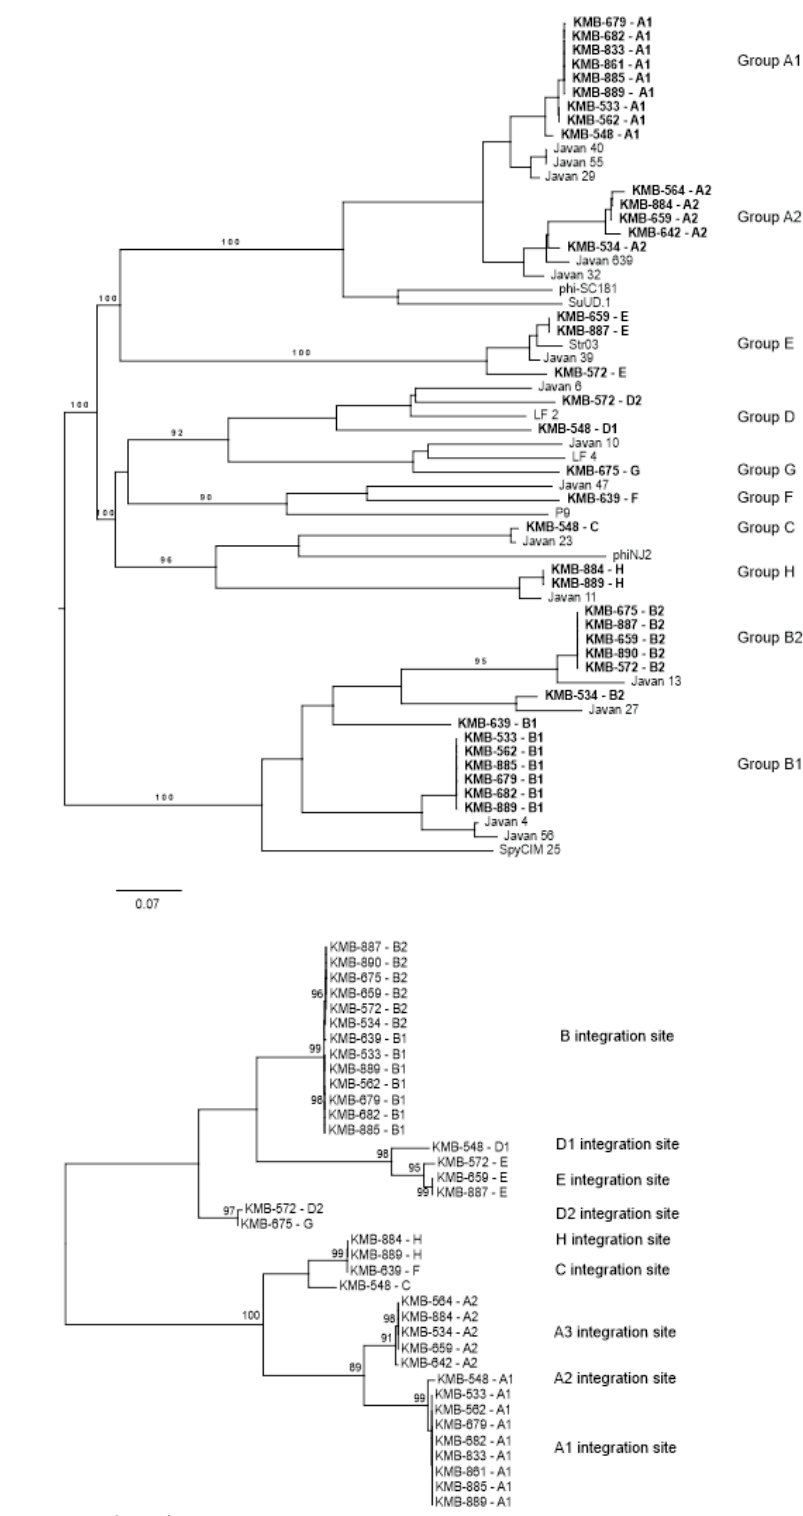
Figure 2. Phylogenetic tree of GBS prophages identified in the present study: ( A ) genome comparison at nucleotide level performed by the Genome BLAST Distance Phylogeny (GBDP) method using the formula D0 available at Victor web software [33]; ( B ) maximum likelihood tree comparing phage integrases at amino acid level in MEGAX using Jones–Taylor–Thornton (JTT) model [34].